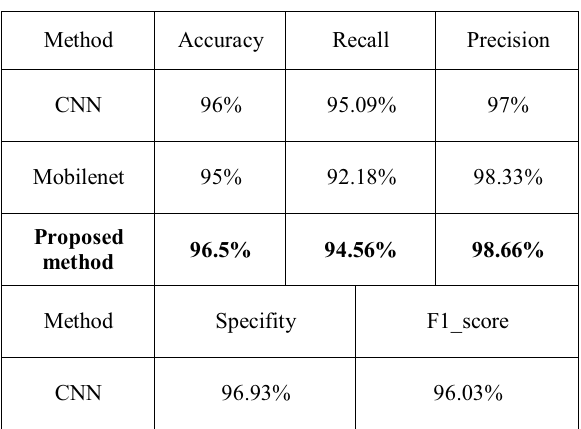
Table 1. Evaluation